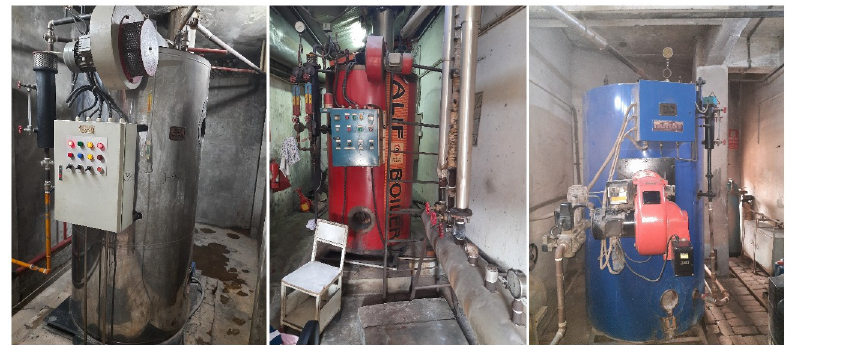
Fig 3. Improper ventilation for the boiler rooms observed during visual inspection.